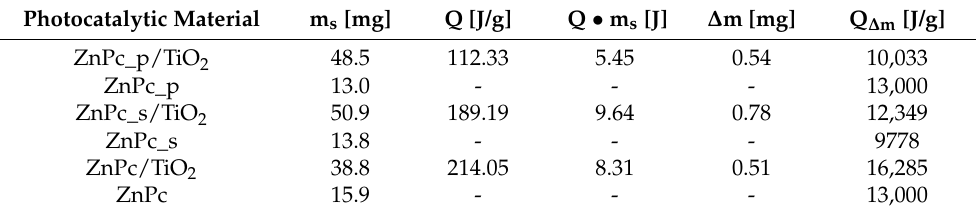
Figure 11. Comparison of the TG and HeatFlow curves between neat phthalocyanines. TG-DSC of each phthalocyanine presented separately is shown in Figures S7 and S8 (TG, HeatFlow and dTG data). Table 5. Comparison of the heat values needed for the combustion of the neat phthalocyanines (ZnPc_p, ZnPc_s, ZnPc) and in the photocatalytic composite with TiO 2 (ZnPc_p/TiO 2 , ZnPc_s/TiO 2 , ZnPc/TiO 2